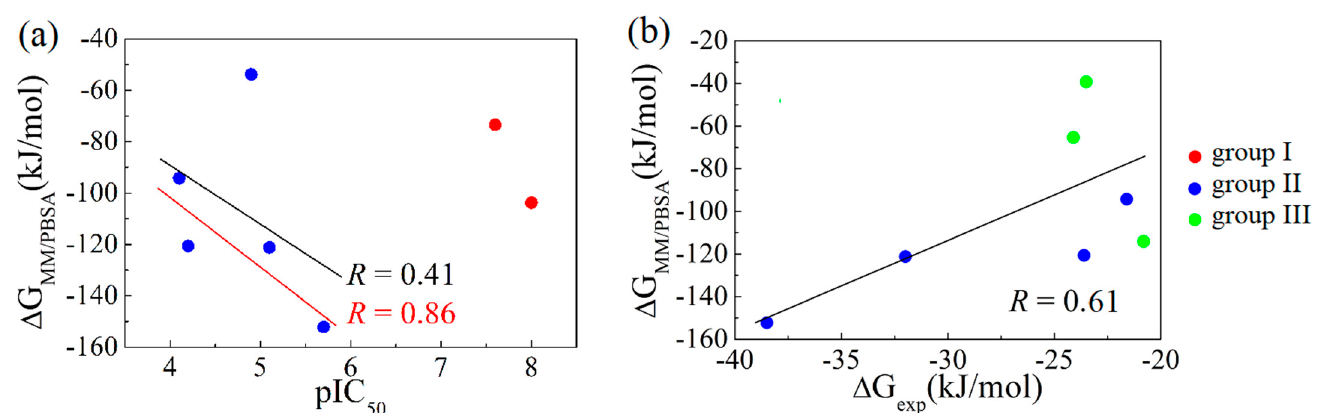
Figure 2. Correlations between available pIC 50 /experimental binding free energies and the averaged binding free energies estimated using the MM/PBSA method for ligand ( a ) in groups I and II, and ( b ) in groups II and III. The three ligand categories are distinguished by red dots for group I, blue dots for group II, and green dots for group III, respectively. In ( a ), the black line fits to all the data points of group II, while the red line to the ones for the group II but ER9. In ( b ), the black line fits to all the data points. Table 3. Comparison of experimental binding energy ( ∆ G exp ) and the estimated binding free energy, ∆ G bind (kJ/mol), at different time scales obtained from MM/PBSA analysis, along with Spearman’s rank correlation coefficient ( ρ ) and Pearson correlation coefficient ( r